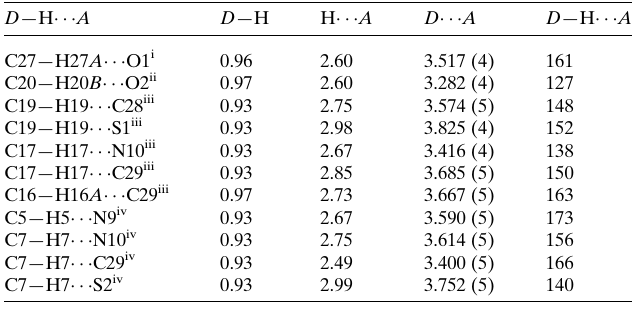
Table 1 Hydrogen-bond geometry (A˚ , (cid:4) ).